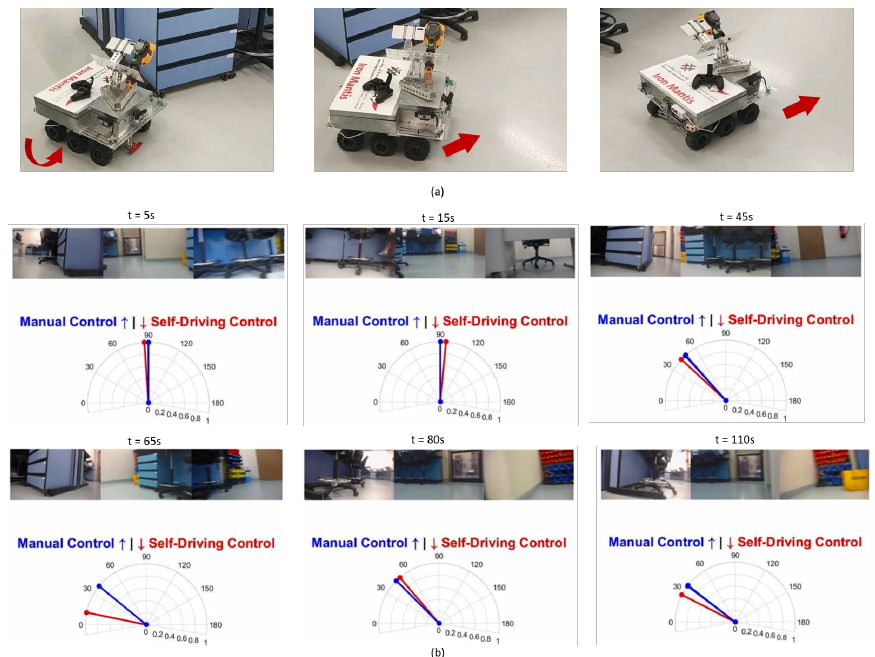
Figure 14. [Lab test run 2] Self-Driving in the lab environment results: Figures in ( a ) show the robot turning around the side bench autonomously then moving forward after turning. Figures in ( b ) represent the robot’s view and the true vs. regressed steering